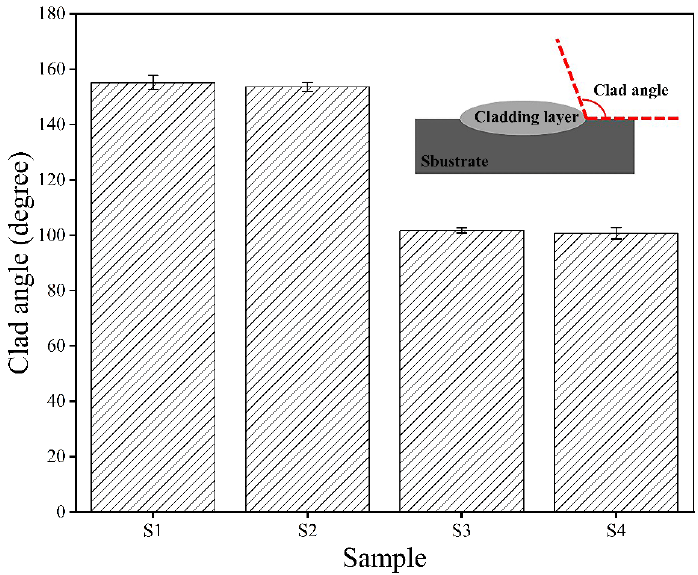
Figure 7. Cladding angles of Stellite 6/WC cladding layer of different specimens.